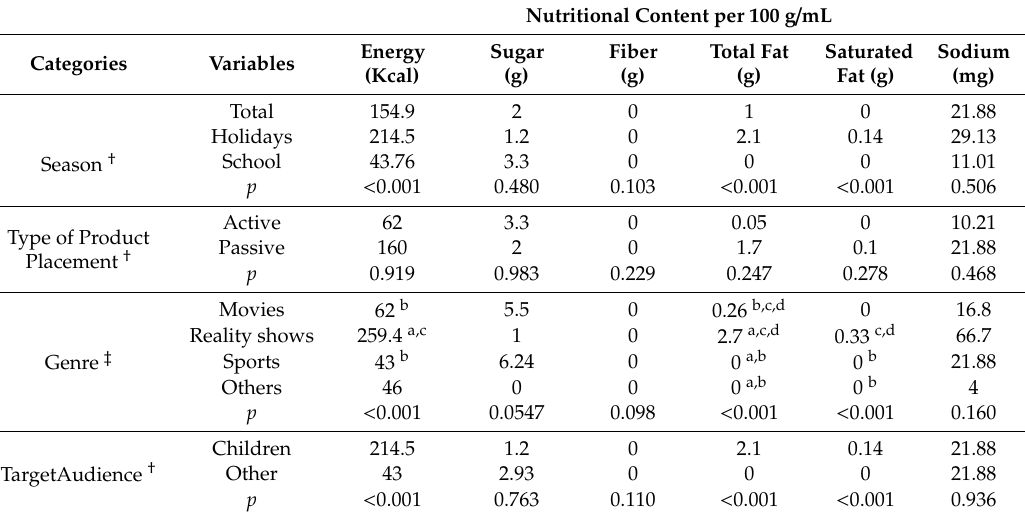
Table 4. Energy and nutrient content per 100 g / mL of food and beverage advertised by product placement on Mexican public television, broadcast from 19 to 22 h.